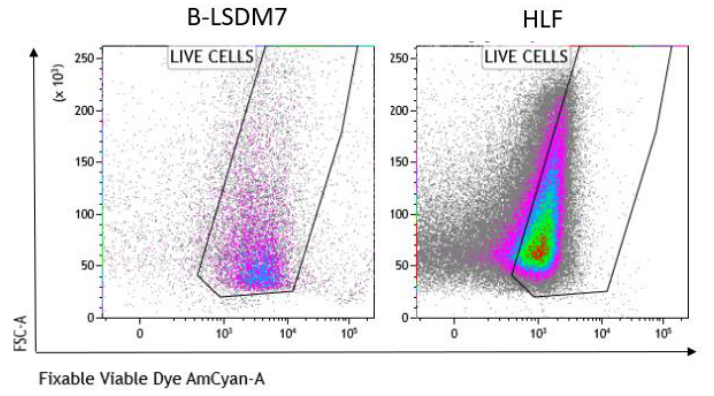
Figure 5. The Flow cytometric analysis of viability in B-LSDM7 and HLF cell lines. Fixable Viable Dye was used for the detection of dead/live cells.